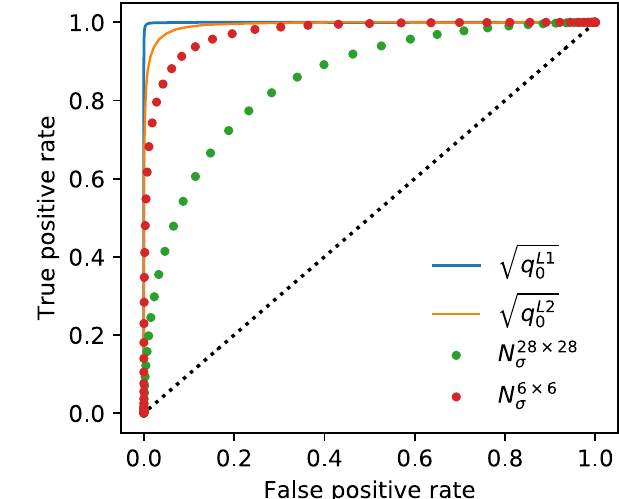
Fig. 3 Significance measured from the Asimov data, with the N σ test applied to increasing window sizes, and compared to the q L 1 significance. Results for the Higgs LFV example and the ideal (flat) scenarioareshown,withinjectedsignalstrengthcorrespondingto5 σ of q L 1 .Thegreenandyellowbandscorrespondtothe1 σ and2 σ deviations 0 from the symmetry (no signal) assumption, respectively